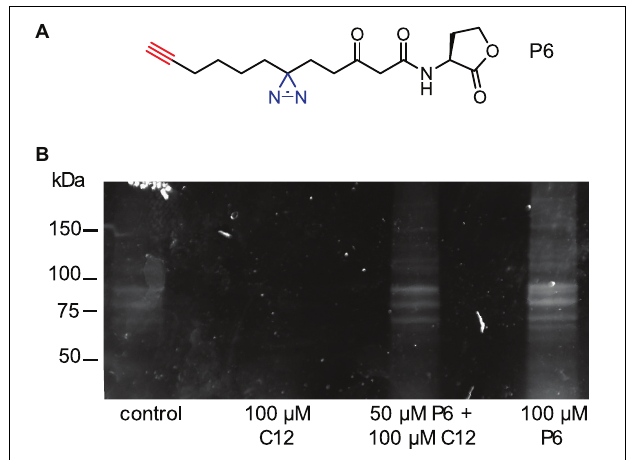
FIGURE 5 | Using a reactive C12 analog probe to label putative C12 receptors in yeast. (A) Structures of C12 analog probe (P6) with small diazirine (blue) and alkyne (red) handles incorporated in order to uncover potential C12-receptor interactions. (B) Labeling experiment. Wild-type S. cerevisiae W303 was incubated for 30 min. with the following treatments: control solutions (DMSO; 100 µ M C12), or two treatments of P6: 50 µ M P6 with 100 µ M C12, or 100 µ M P6. The cultures were irradiated at 365 nm for 10 min on a UV table to activate covalent binding on the diazirine position to any interacting proteins. Then, cells were lysed and the lysate reacted with rhodamine azide using CuAAC chemistry, resulting in a rhodamine-labeled probe-protein complex. Labeled proteins were visualized using in-gel